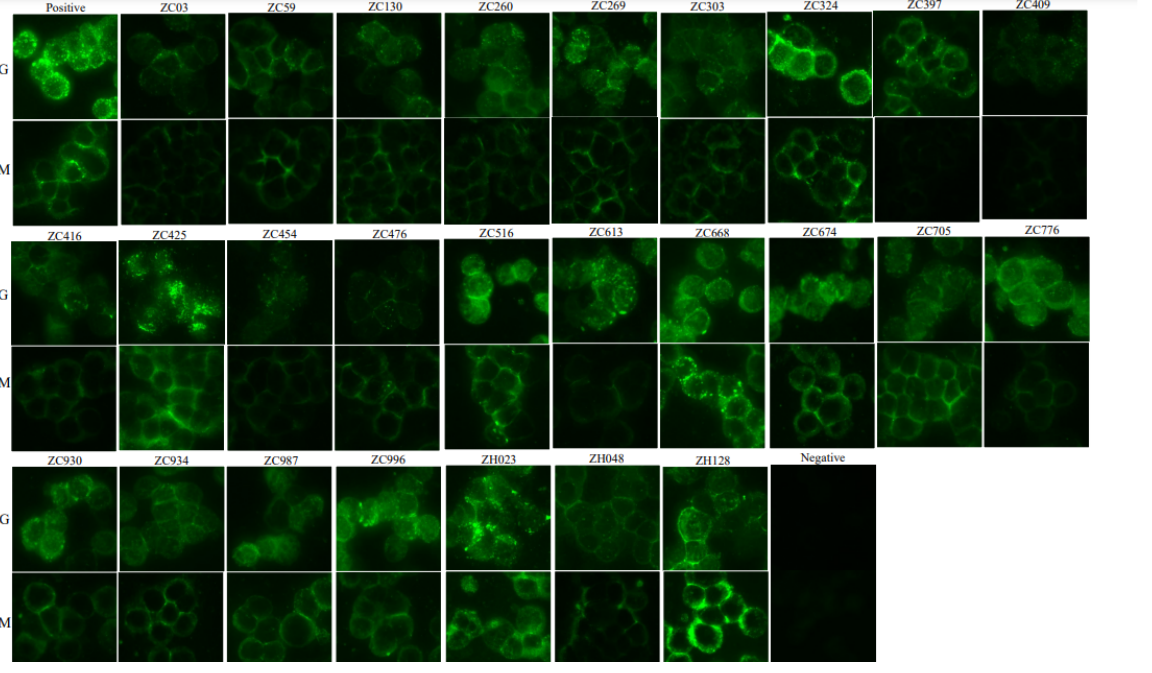
Figure 1. Immunofluorescence assay for IgG and IgM in healthy residents in Vietnam. Serum dilu ‐ tion: 1:80.